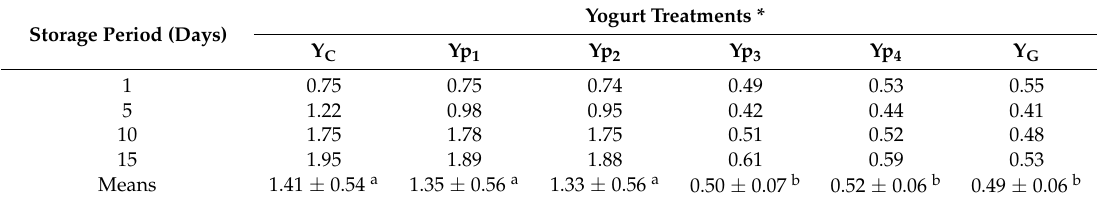
Table 4. Mean values of total acidity in yogurt manufacturing at 5 ◦ C for 15